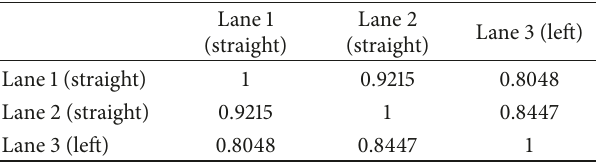
Table 10: Correlation coefficient matrices of two traffic volume series from three adjacent lanes in a section of the urban arterial